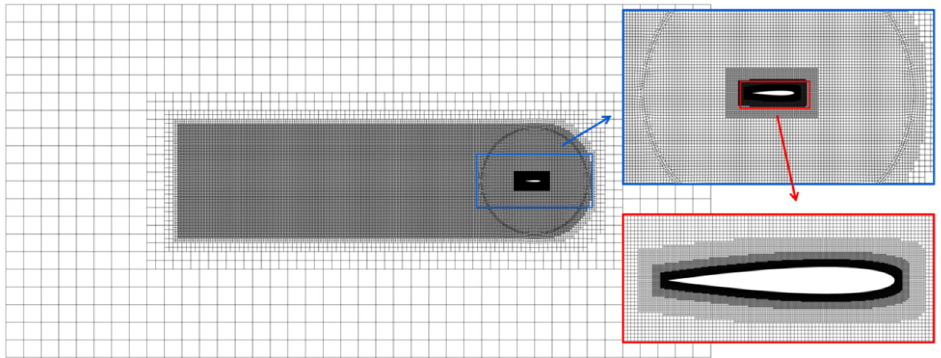
Figure 2. Main features of the computational domain and gradual mesh